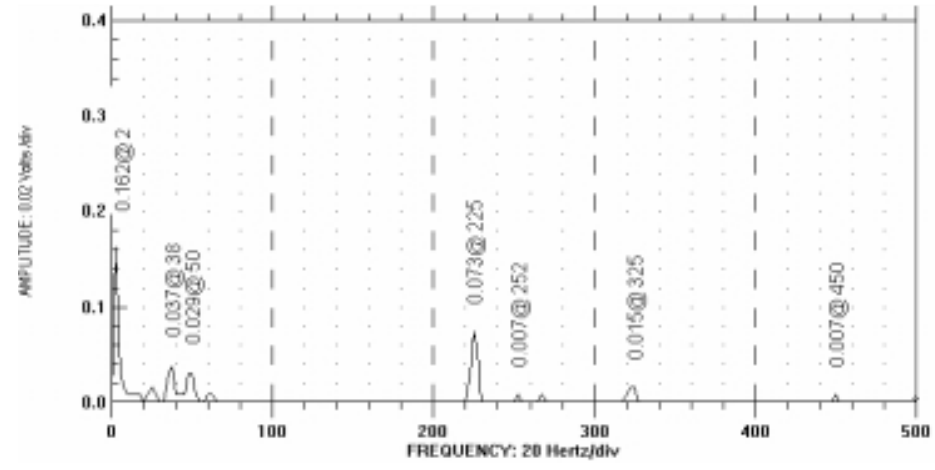
Fig. 30. Frequency spectrum of the PZT signal for the free vibration